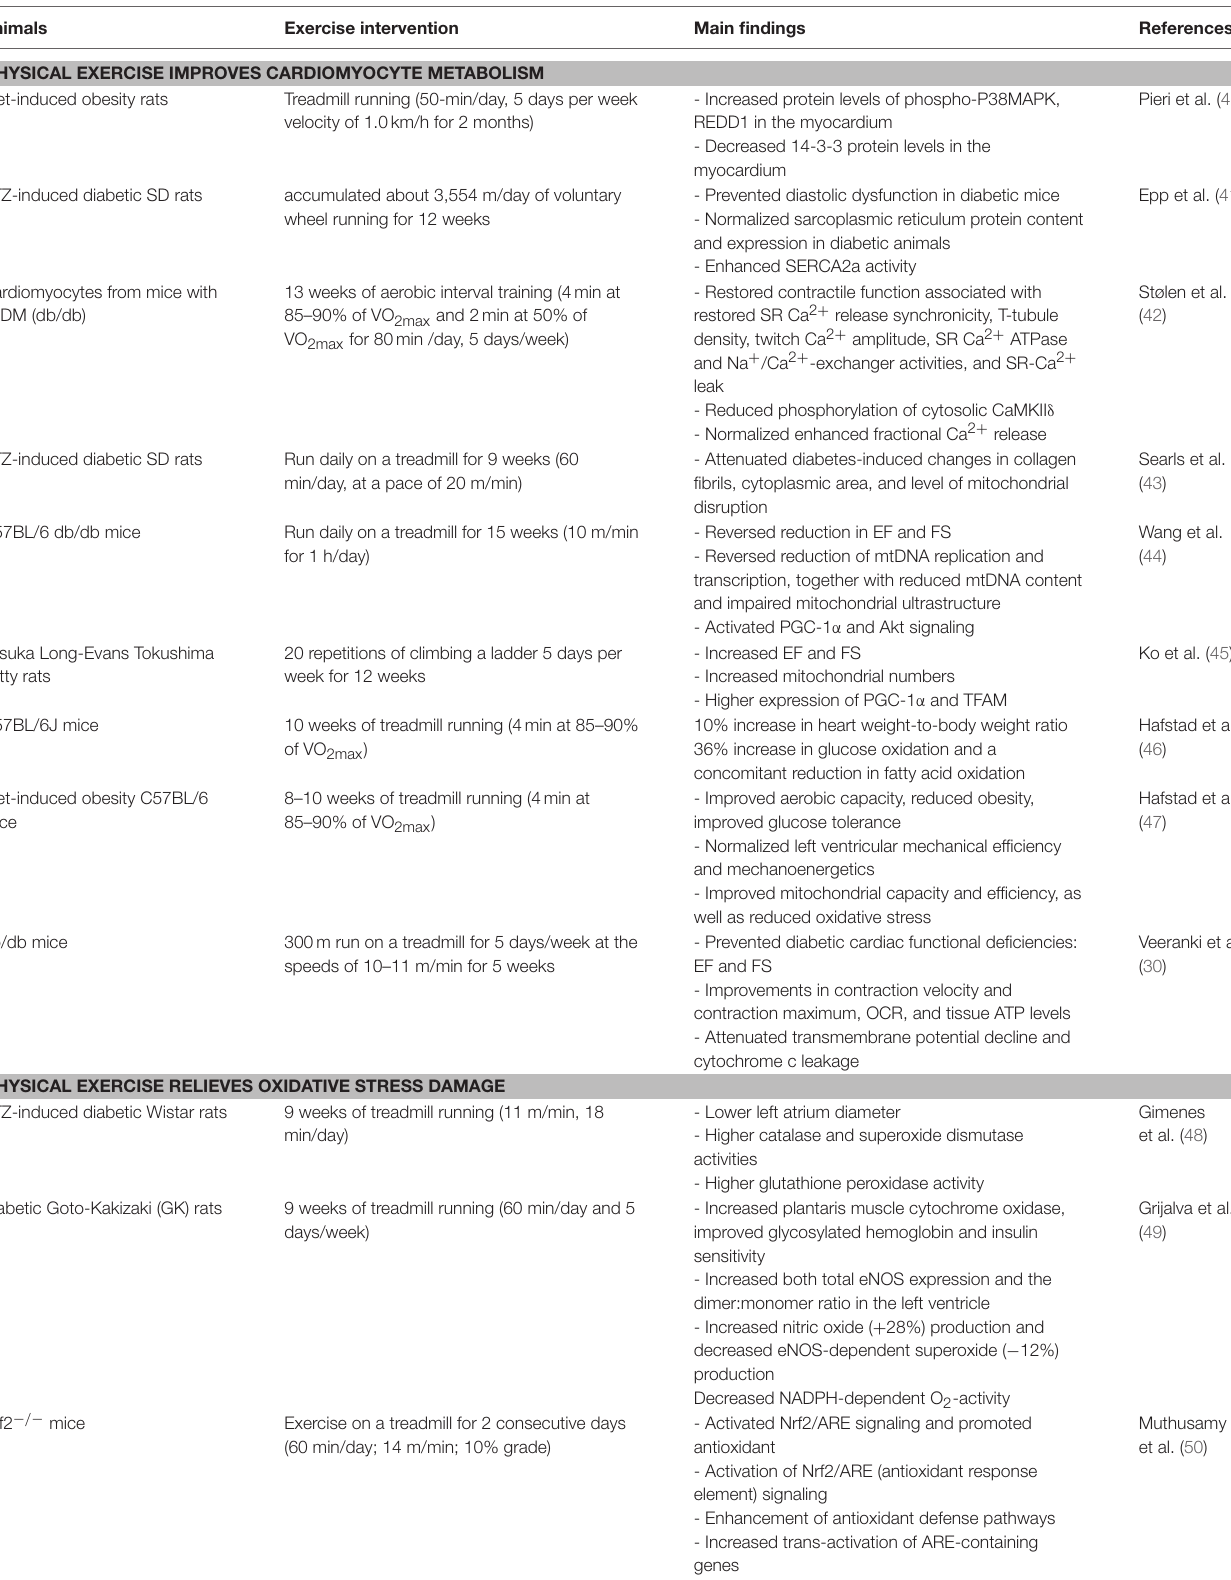
TABLE 2 | Pre-clinical experiments about physical exercise and DCM.